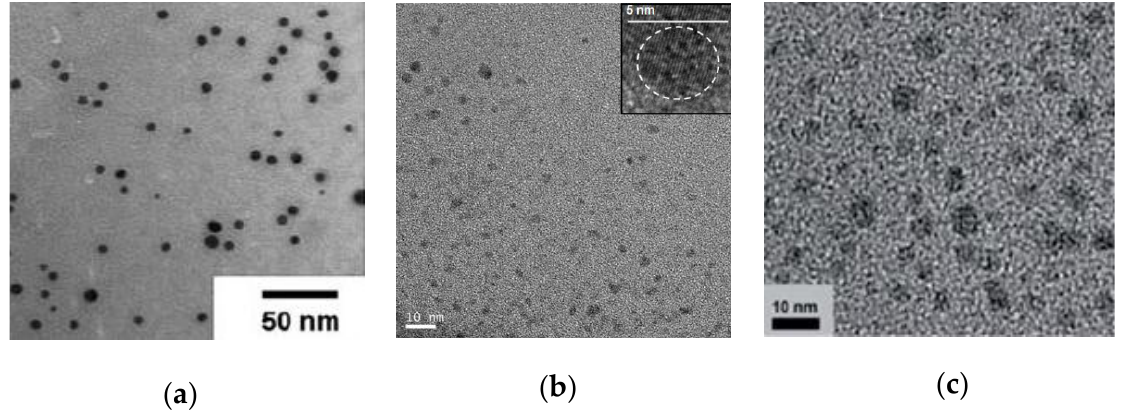
Figure 6. Examples of nanomaterials synthesized by using SCNPs as individual nanoreactors: ( a ) gold nanoparticles (Au-NPs); ( b ) cadmium sulfide quantum dots (CdS-QDs), dash circle in the inset shows a single CdS-QD; and, ( c ) carbon nanodots (C-NDs) (reprinted with permission from [32], Copyright Royal Society of Chemistry, 2011; [33], Copyright Wiley-VCH, 2012; and, [34], Copyright Royal Society of Chemistry,